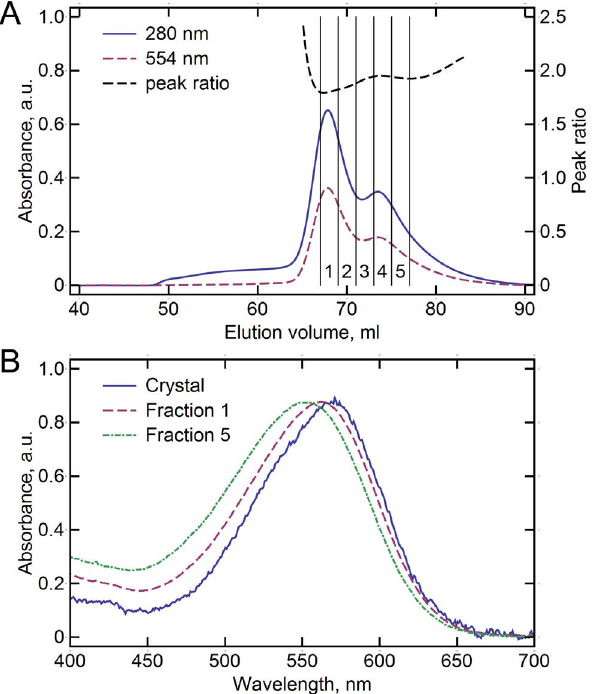
Figure 1. Hm BRI size-exclusion chromatography (SEC) elution profile and visual light absorbance spectra in different environments. (A) SEC elution profile of Hm BRI. Two distinct peaks are observed, that correspond supposedly to monomeric Hm BRI (at 73.4 ml, peak ratio is , 1.95) and oligomeric Hm BRI (at 67.8 ml, peak ratio is , 1.85). Five 2 ml fractions (1–5) were collected for subsequent crystallization. (B) Spectra of the light-adapted Hm BRI in the hexagonal crystals, the first and the fifth SEC fractions.